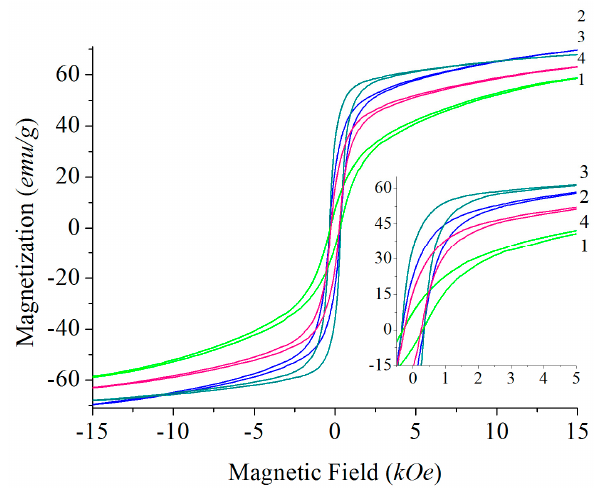
Figure 6. Hysteresis loops of barium hexaferrite samples BaFe 12 O 19 : 1 (light green), obtained from solid-state sintering; 2 (blue), from carbonate flux; 3 (dark green), from borate flux; and 4 (red), from PbO flux (composition Ba 0.77(2) Pb 0.23 Fe 12 O 19 , compare with Table 2). Insert figure: Detailed view of the section between 0 and 5 kOe.